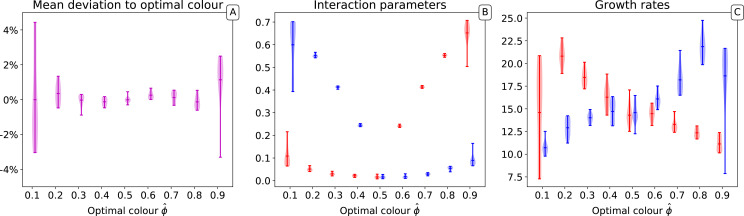
Distribution of the final traits across several experiments for different optimal colours.Ten independent simulations are performed for each value of ϕ^. In all simulations, D=100 collectives, M= 10,000 generations, B=15 particles, and initial particle traits are (r0=r1=5,a0intra=a1intra=0.7/K,a0 inter=a1inter=0.3/K), with K=1500.